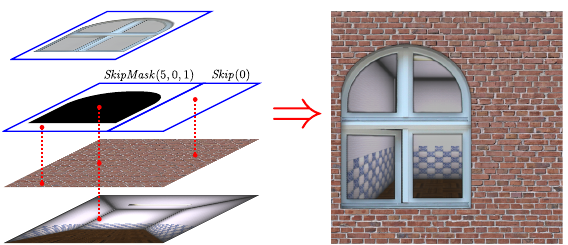
Figure 8: Skipping of underlying layers is an intuitive way for cutting holes into the wall in order to see the room behind. The SkipMask operator decides how many layers are skipped depend- ing on the sampled bit value whereas the Skip operator skips the defined number of layers for the whole scope. In the example, we create another layer over the hole that samples a window texture to produce the final tile that is shown on the right side.